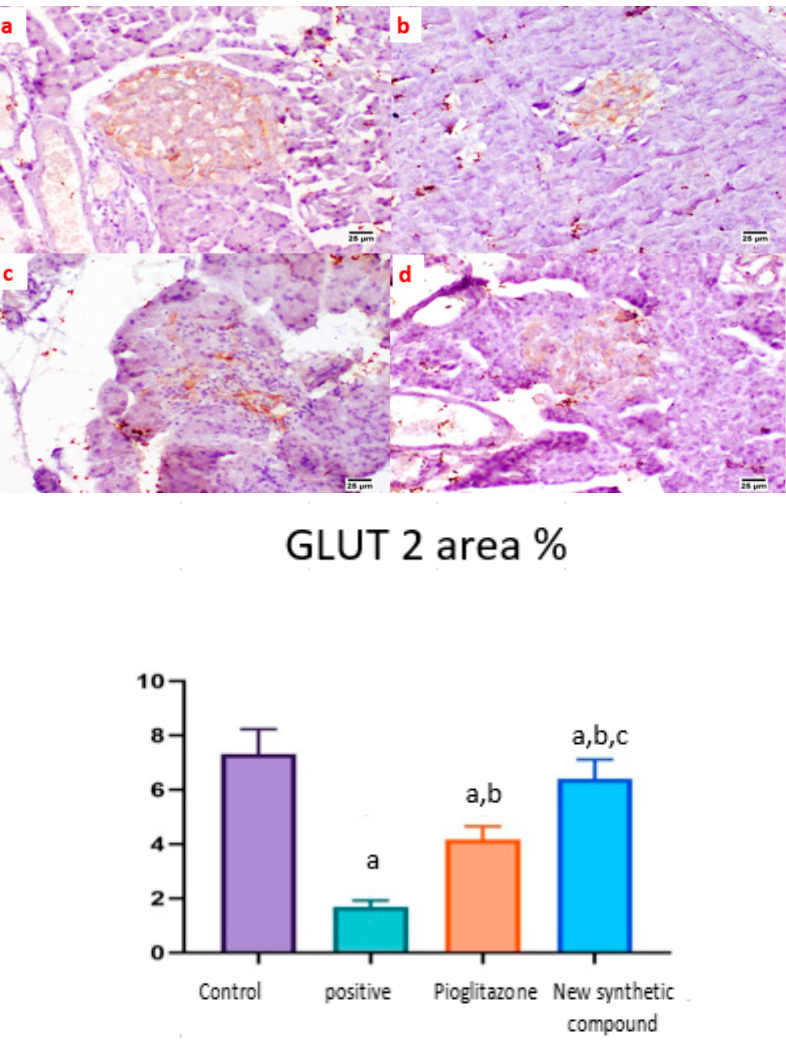
Figure 9. Photomicrographs of rat pancreatic immunostained section for glucose transporter 2 (GLUT 2) showing the effect of 14 days of oral administration of pioglitazone and the synthetic compound against STZ-induced type 2 DM. ( a ) Normal control section (25 µ m) showing a high expression of GLUT-2 in pancreatic islets of Langerhans; ( b ) positive control group section (25 µ m) showing limited expression of GLUT-2 in the islets of Langerhans; ( c ) pioglitazone treatment section (25 µ m) showing increased expression of GLUT-2 in the islets of Langerhans; ( d ) synthetic compound section (25 µ m) showing positive expression of GLUT-2 in the islets of Langerhans. The statistical analysis showed a significant increase in the normal, pioglitazone, and benzosulfonamide derivative in comparison with the positive control group. On the contrary, GLUT 2 % statistical analysis showed a significant increase in normal control group, pioglitazone standard group and benzosulfonamide derivative in comparison to positive control group. While, benzosulfonamide derivative groups showed significant increase in GLUT 2% in compared to positive control and pioglitazone groups (Figure 9). Immune expression of GLUT 2 as area %. Data are presented as means ± SE. Significant difference was considered at p > 0.05. a: Significantly different from the normal control group, b: Significantly different from the positive control group, c: Significantly different from the pioglitazone group at p <